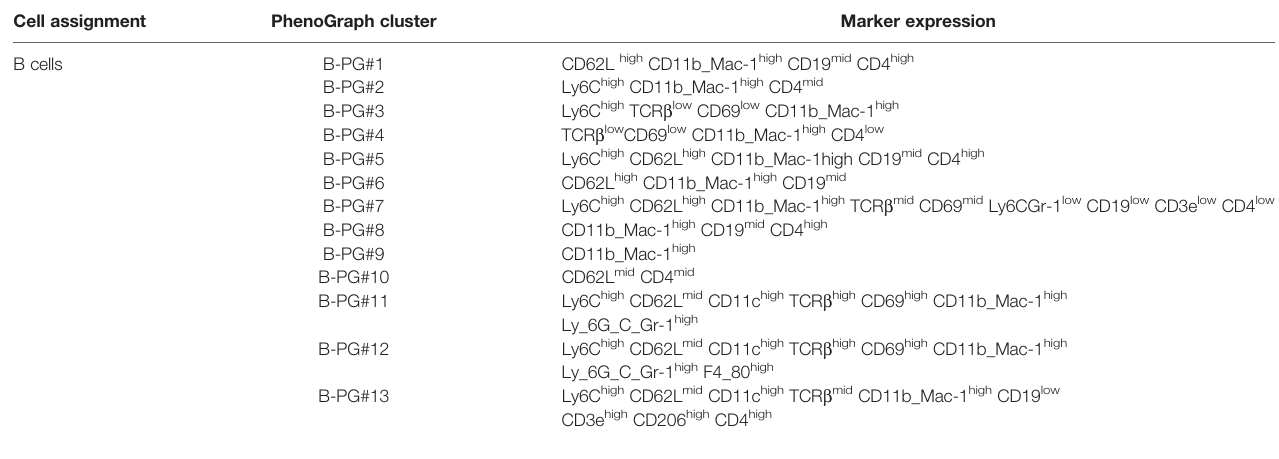
TABLE 4 | Comparison of B cell PhenoGraph clusters with manually gated population and associated marker expression. Cell